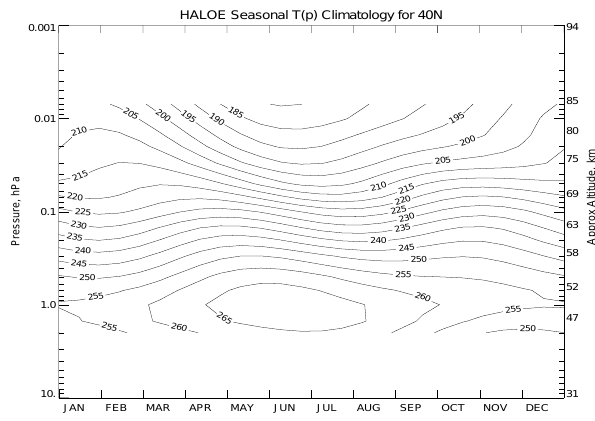
ery latitude and pressure-altitude, both terms are included in